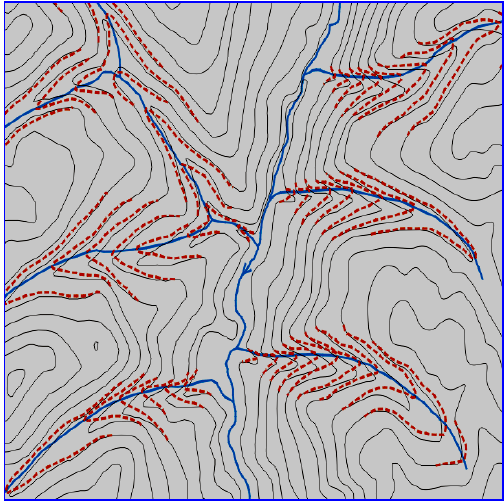
Figure 11. Displacement of contour to match river network